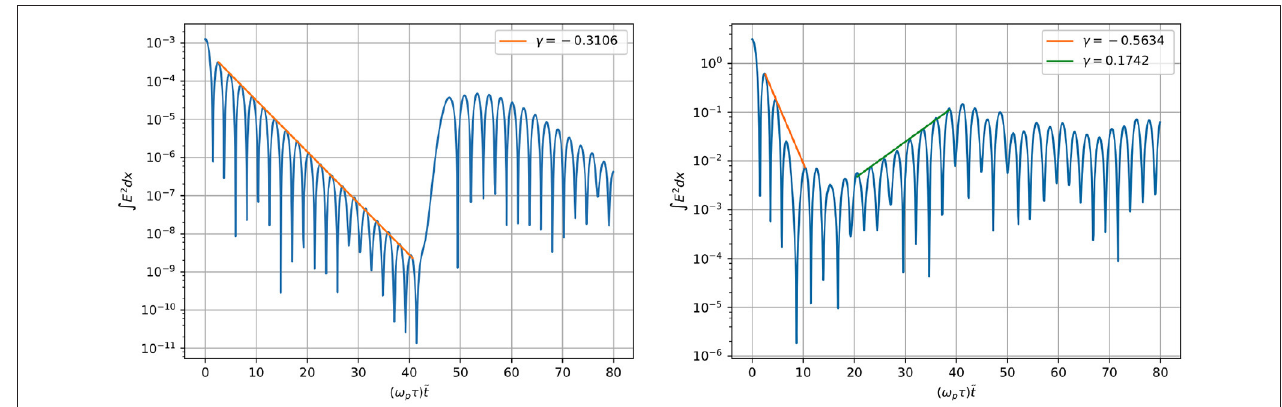
FIGURE 2 | Evaluation of electric field energy for the weak (Left) and strong (Right) Landau damping problem. For the weak damping problem, a damping rate of 0.3106 is measured, compared with a theoretical rate of 0.3066. For the strong damping problem, a damping and growth rate of − − measured, compared with 0.562 and 0.168, respectively from published −